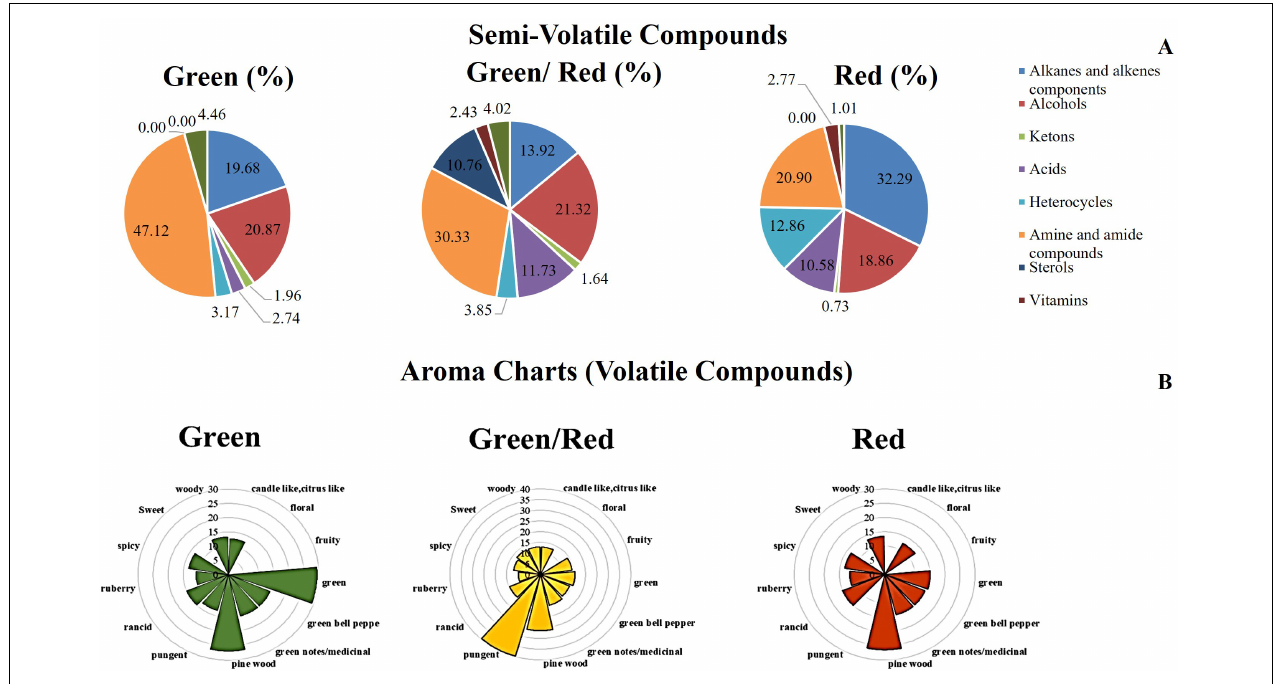
FIGURE 4 | (A) Cake representation of distribution (%) of Semi-volatile classes detected in each sample ( Supplementary Table 2 ). (B) Aroma chart depicting the sweet pepper ( Capsicum annuum L.) aroma properties of green, green/red, and red development stage. Axis showing peak area is ln transformed (